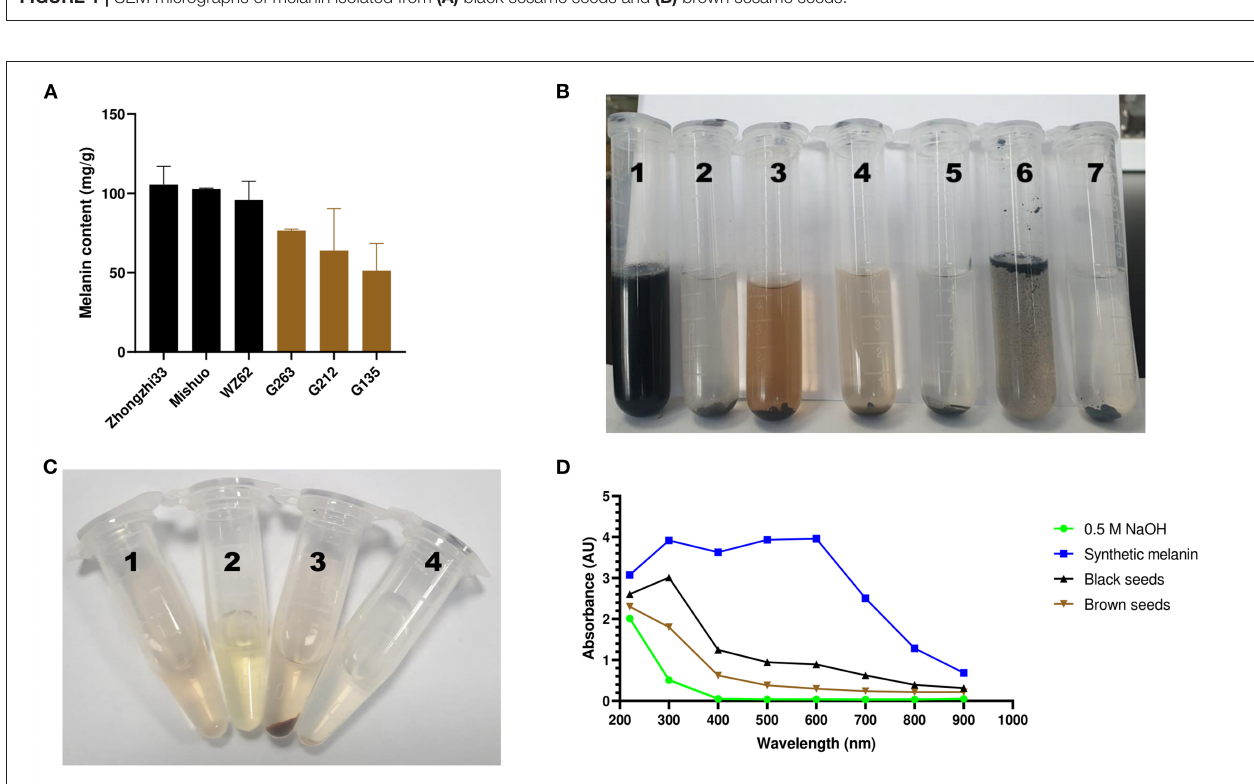
FIGURE 2 | Variation, chemical, and UV-Vis absorbance characteristics of sesame melanins. (A) variation of melanin content in black and brown sesame seeds. (B) Solubility of the black sesame melanin. The serial numbers 1–7 on the tube correspond to melanin in an alkaline solution (0.5M NaOH), H 2 O (pH 6.8), methanol (80%), ethanol, isopropyl alcohol, chloroform, and hexane, respectively. (C) Precipitation of the brown sesame seed melanin. The serial numbers 1–4 correspond to melanin in a sodium hydroxide solution (1 mg/mL) + 125 µ L of ddH2O, 500 µ L of ddH2O + 125 µ L of 10 % FeCl 3 , melanin in a sodium hydroxide solution (1 mg/mL) + 125 µ L of 10 % FeCl 3 , and melanin in a sodium hydroxide solution (1 mg/mL, pH 8.0) + 80 µ L of 6 mol/L HCl. (D) UV–spectroscopy absorbance spectra of a synthetic melanin and the melanin pigments isolated from black and brown sesame